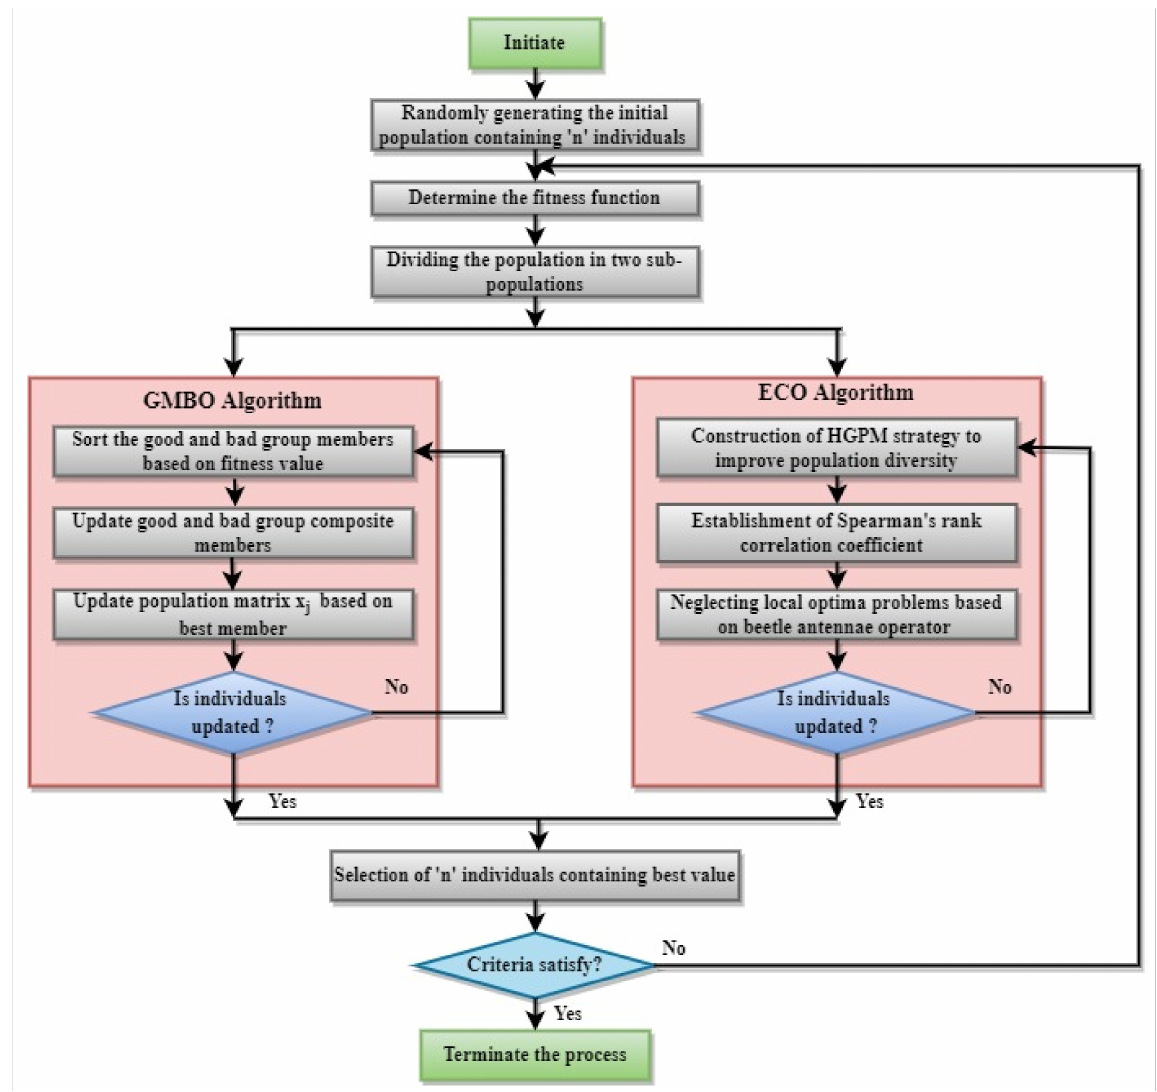
Figure 2. Hybrid GMBO-ECO